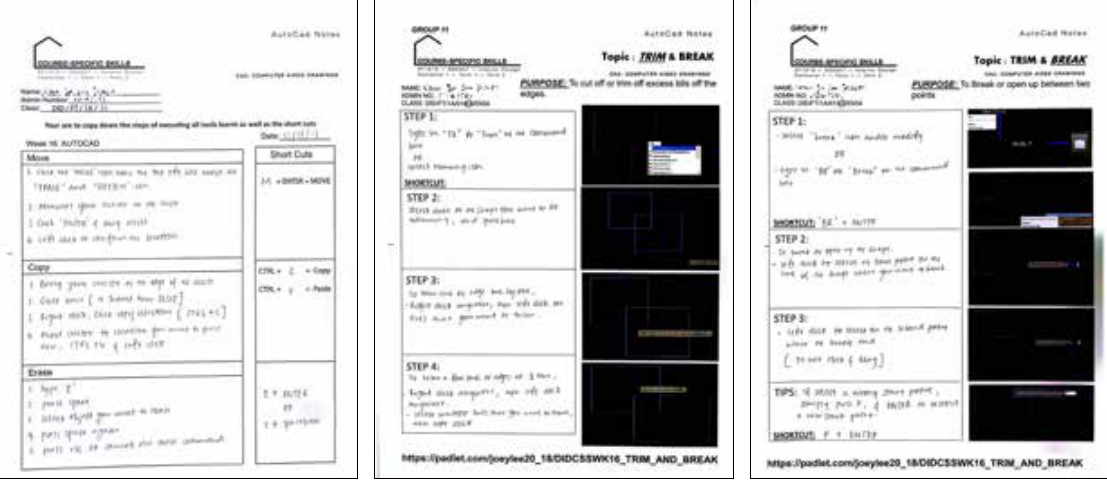
Figure 8: Sample tutorial slides. Source: author